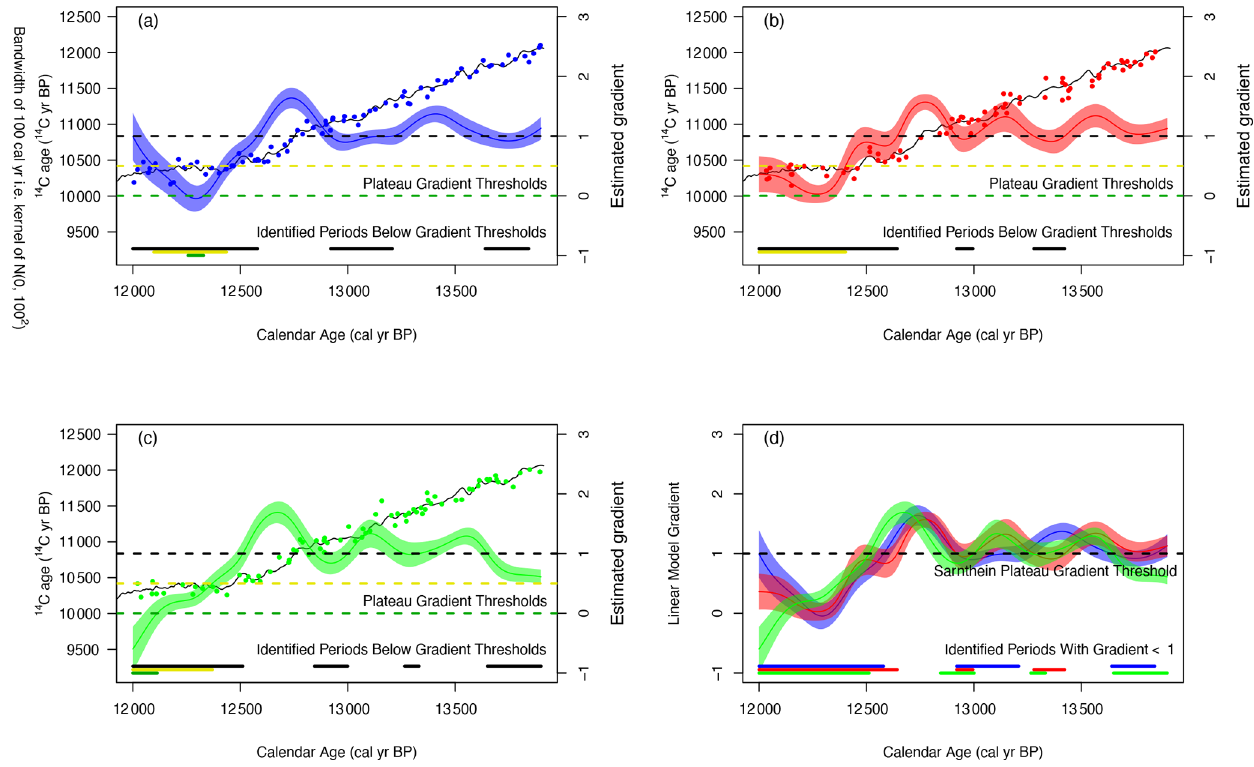
Figure 6. The same as Fig. 5 but using a wider N (0 , 100 2 calyr 2 ) kernel to provide the weightings for the local gradient estimate. The same three simulated atmospheric cores are